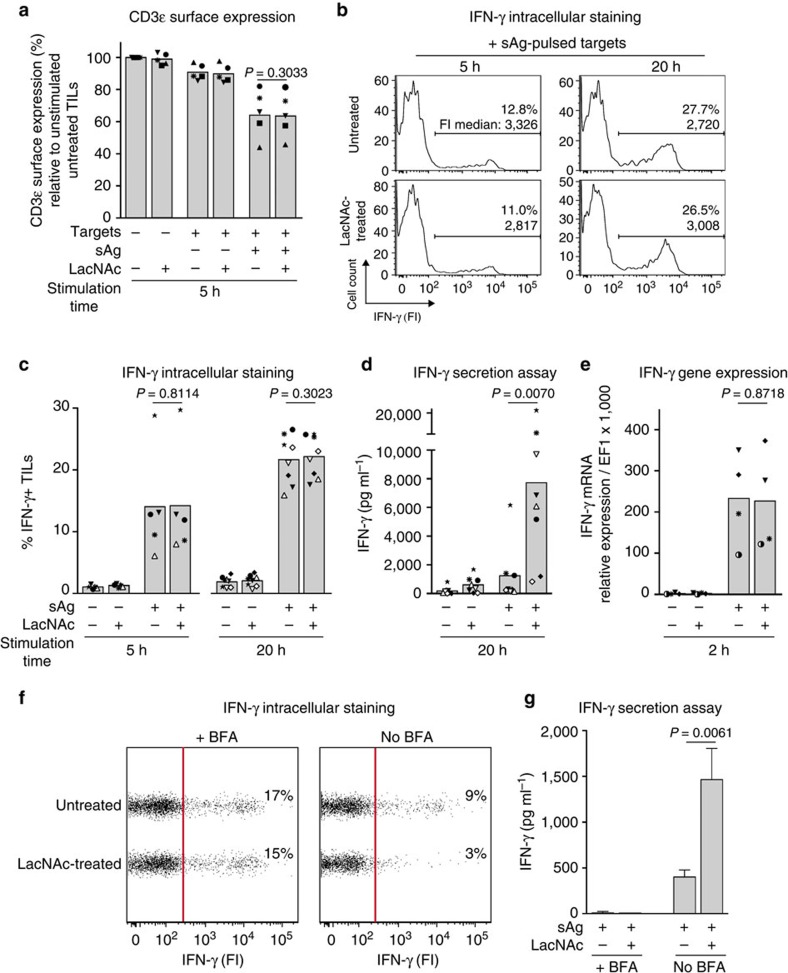
LacNAc treatment is dispensable for TCR internalization and IFN-γ production by TILs.CD8 TILs were isolated from ascites and treated with LacNAc. TILs were cultured with sAg-pulsed EBV-B cells. Each symbol represents TILs from one patient (Supplementary Table 1). (a–e) Data were obtained in the same experiment for each patient. Columns represent means for several patients. Paired t-test. (a) Cells were stained with anti-CD3ɛ mAb. Data represent the percentage of CD3ɛ surface expression on TILs, relative to unstimulated conditions. (b,c) Intracellular staining of IFN-γ in TILs cocultured with sAg-pulsed targets in the presence of brefeldin A. (b), Representative histograms obtained from patient Gdc44 (●), % of IFN-γ+ TILs and the fluorescence intensity (FI) median of the positive subset are indicated (c), % of IFN-γ+ TILs obtained from each patient. (d) IFN-γ secretion was measured by Bioplex. (e) IFN-γ messenger RNA expression was measured by quantitative PCR with reverse transcription. (f) After 5 h of coculture in the presence or in the absence of brefeldin A (BFA), TILs from sample Gdc42 were stained for intracellular IFN-γ and analysed by flow cytometry. Data at the right of the red line are considered as positive for IFN-γ staining. (g) In the same experiment, IFN-γ release was measured in the supernatants by enzyme-linked immunosorbent assay (ELISA). Columns represent mean±s.d. of triplicates. Unpaired t-test. (f,g) Results are from one representative experiment out of three.